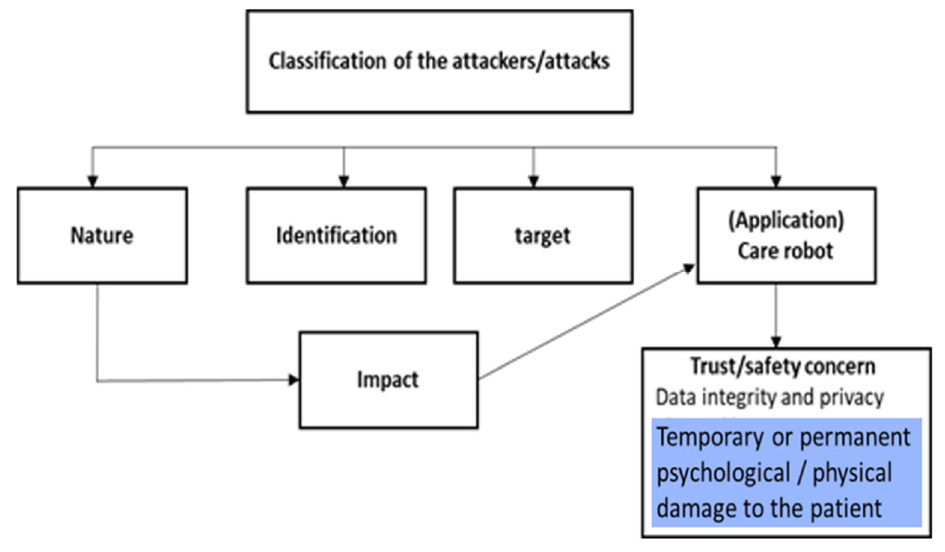
Figure 2. Model of robot-related threats, causes, and consequences.